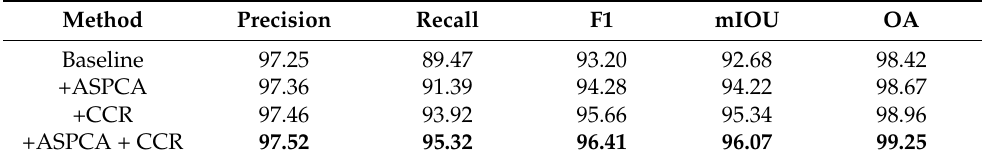
Table 3. Ablation study of different modules on CCD dataset. The bold type indicates the best results.